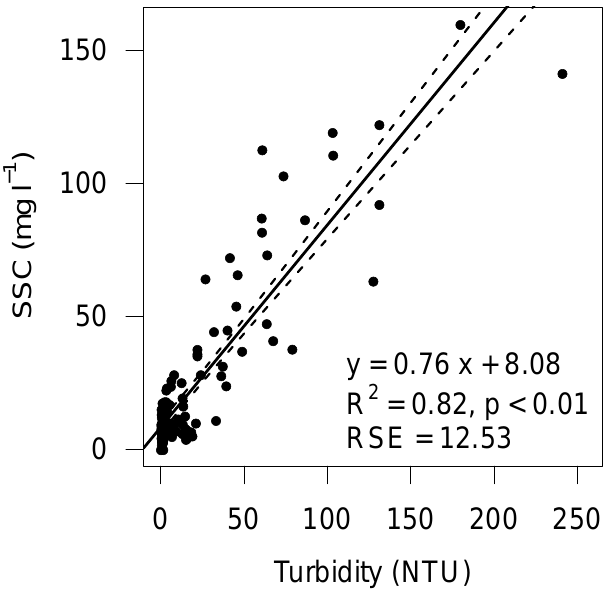
Fig. 3. Correlation between turbidity in NTU and suspended sed- iment concentration (SSC). Dashed lines are the 95% confidence intervals; RSE=residual standard error (degree of freedom=154)